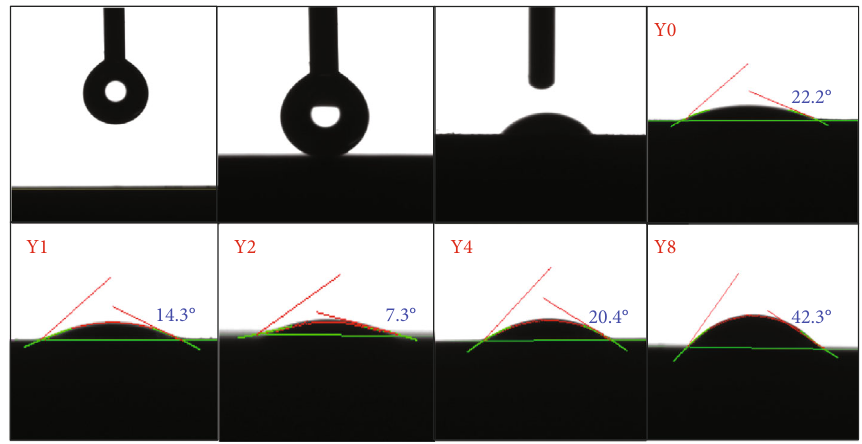
Figure 11: Contact angle of sample N0. 1 saturated with slick water for 1, 2, 4, and 8 days.